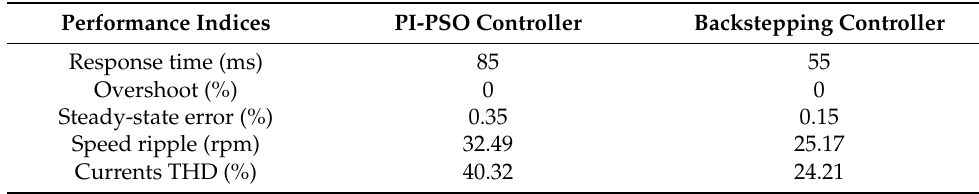
Table 2. The comparative performances of the backstepping-type controller versus PI-PSO-type